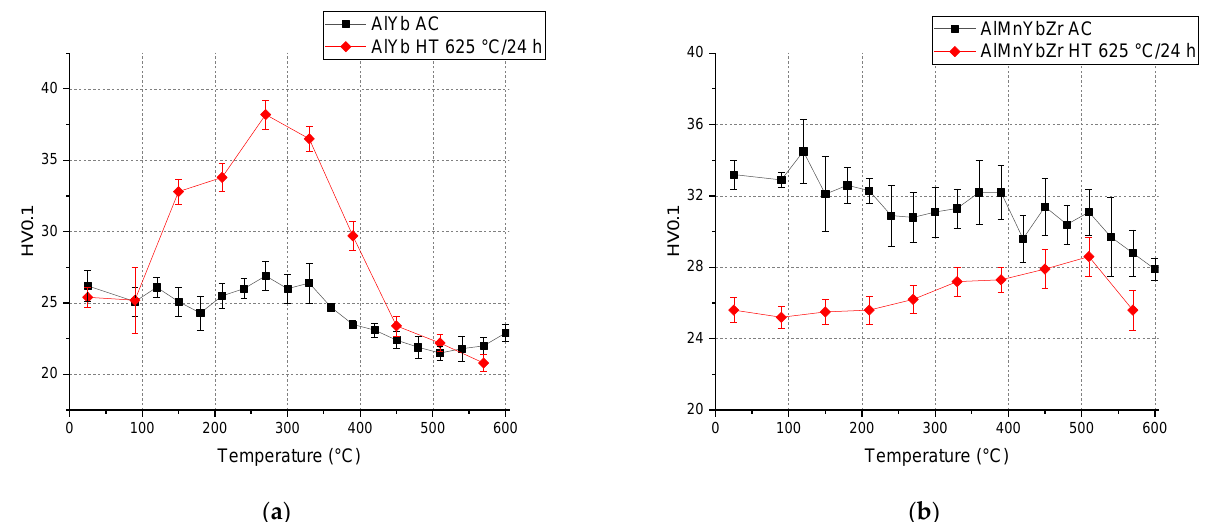
Figure 12. Isochronal ageing curves of microhardnes changes HV0.1 for the ( a ) AlYb AC and HT alloys and ( b ) AlMnYbZr AC and HT alloys. Isochronnal treatment of AC alloys was done in steps of 30 °C/30 min and of HT alloys in steps of 60 °C/120 min.